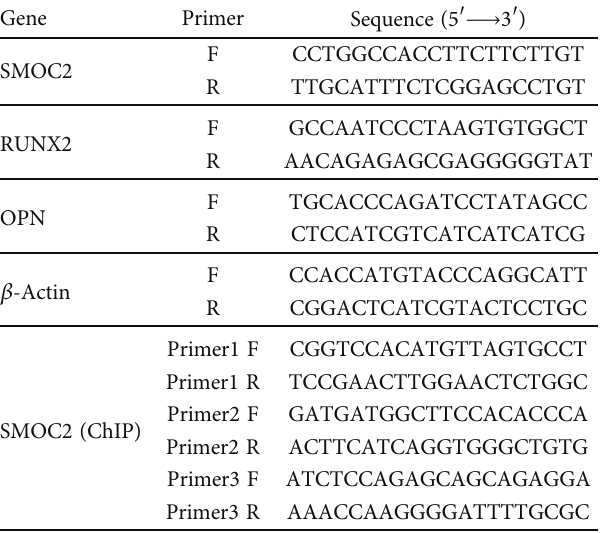
Table 1: The primers used for PCR.